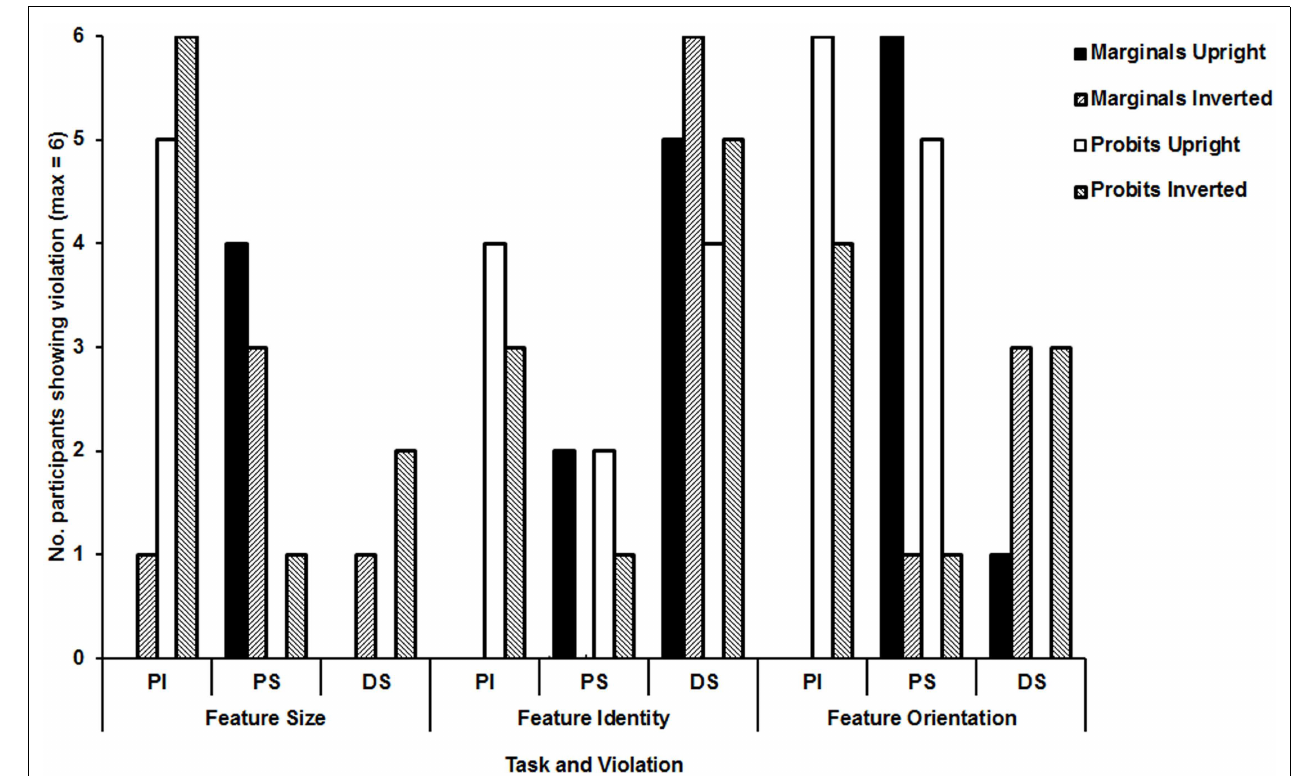
FIGURE 4 | Summary of significant violations in marginal and probit analyses for each of the tasks and orientation